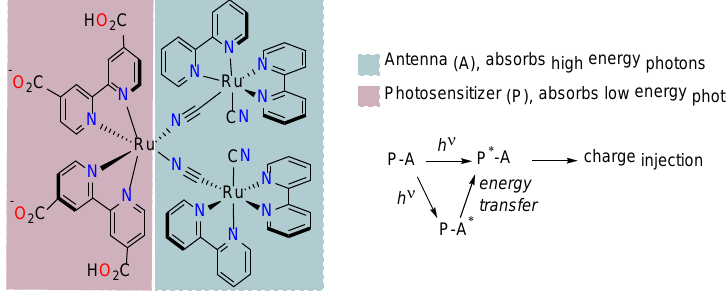
Figure 5. Trinuclear ruthenium complex. Antenna moieties improve light absorption in high energies.